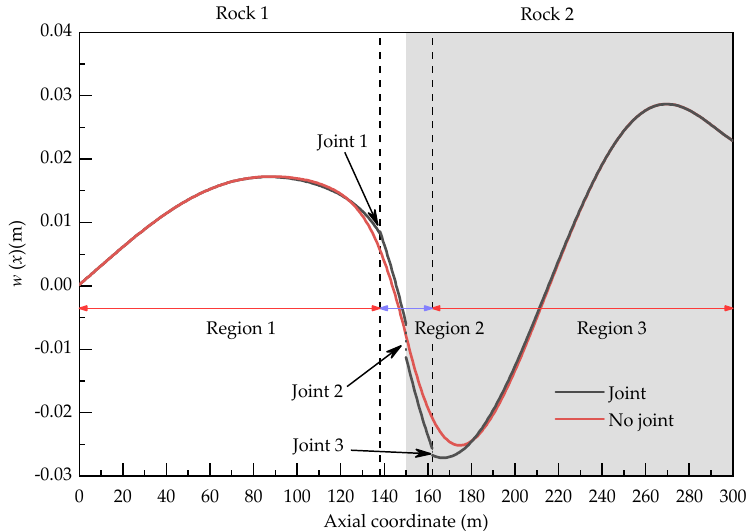
Figure 6. Displacement along the tunnel axis.